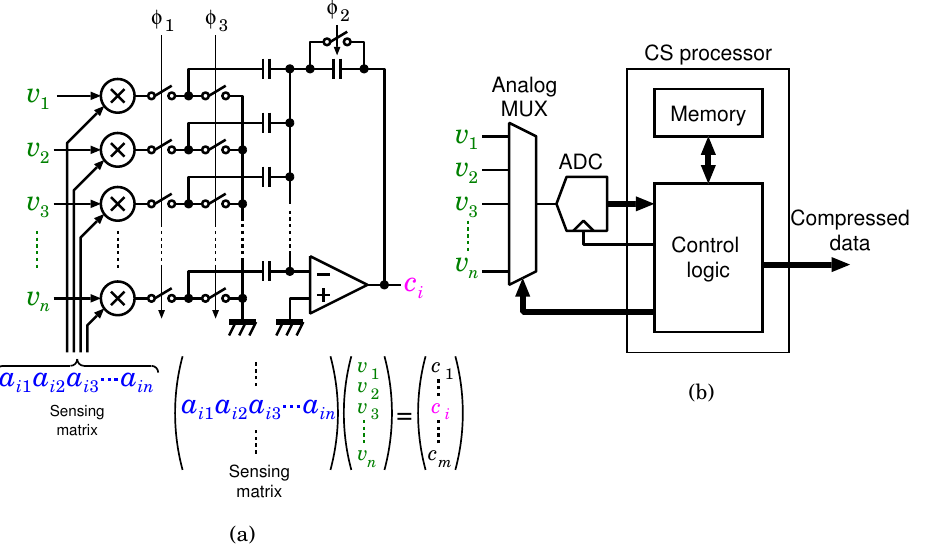
Figure 3. Conventional CS encoder implementation of ( a ) voltage-domain analog circuits, and ( b ) digital